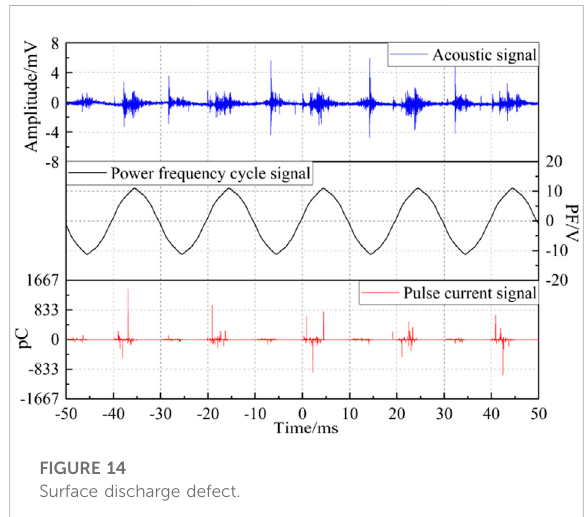
FIGURE 12 Pollution defect.